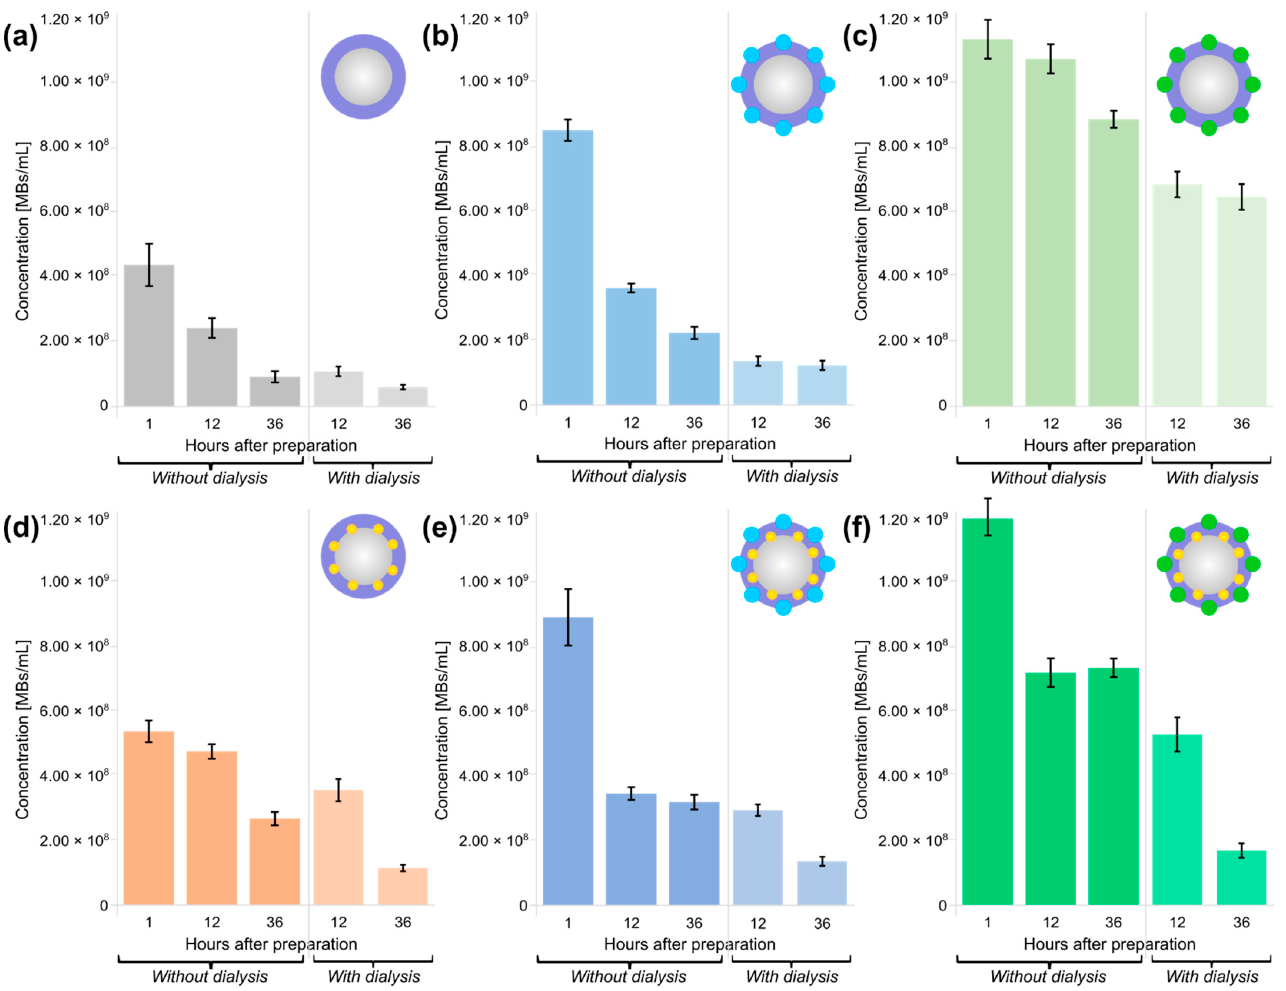
Figure 4. Bubbles concentrations and stability during storage time for probes without dialysis at 1, 12, and 36 h after prep-aration, and for dialyzed probes at 12 and 36 h after preparation: ( a ) microbubbles with the BSA shell only (BSA MBs), ( b ) microbubbles functionalized with ZnPc (BSA-ZnPc MBs), ( c ) microbubbles functionalized with ICG (BSA-ICG MBs), ( d ) microbubbles stabilized with AuNPs (BSA-AuNPs MBs), ( e ) microbubbles stabilized with AuNPs and ZnPc (BSA-ZnPc-AuNPs MBs), ( f ) microbubbles stabilized with AuNPs and ZnPc (BSA-ZnPc-AuNPs MBs). All samples were stored at 4 °C.